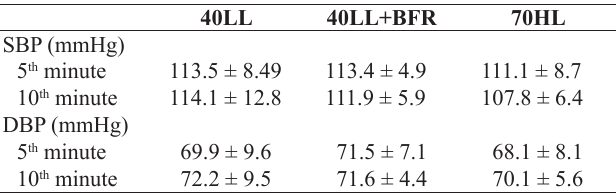
SBP: Systolic blood pressure; DBP: Diastolic blood pressure. 40LL: 10 minutes of aerobic exercise at 40% of maximal aerobic speed; 40LL+BFR: 10 minutes of aerobic exercise at 40% of maximal aerobic speed with blood flow restriction; 70HL: 10 minutes of aerobic exercise at 70% of maximal aerobic speed.